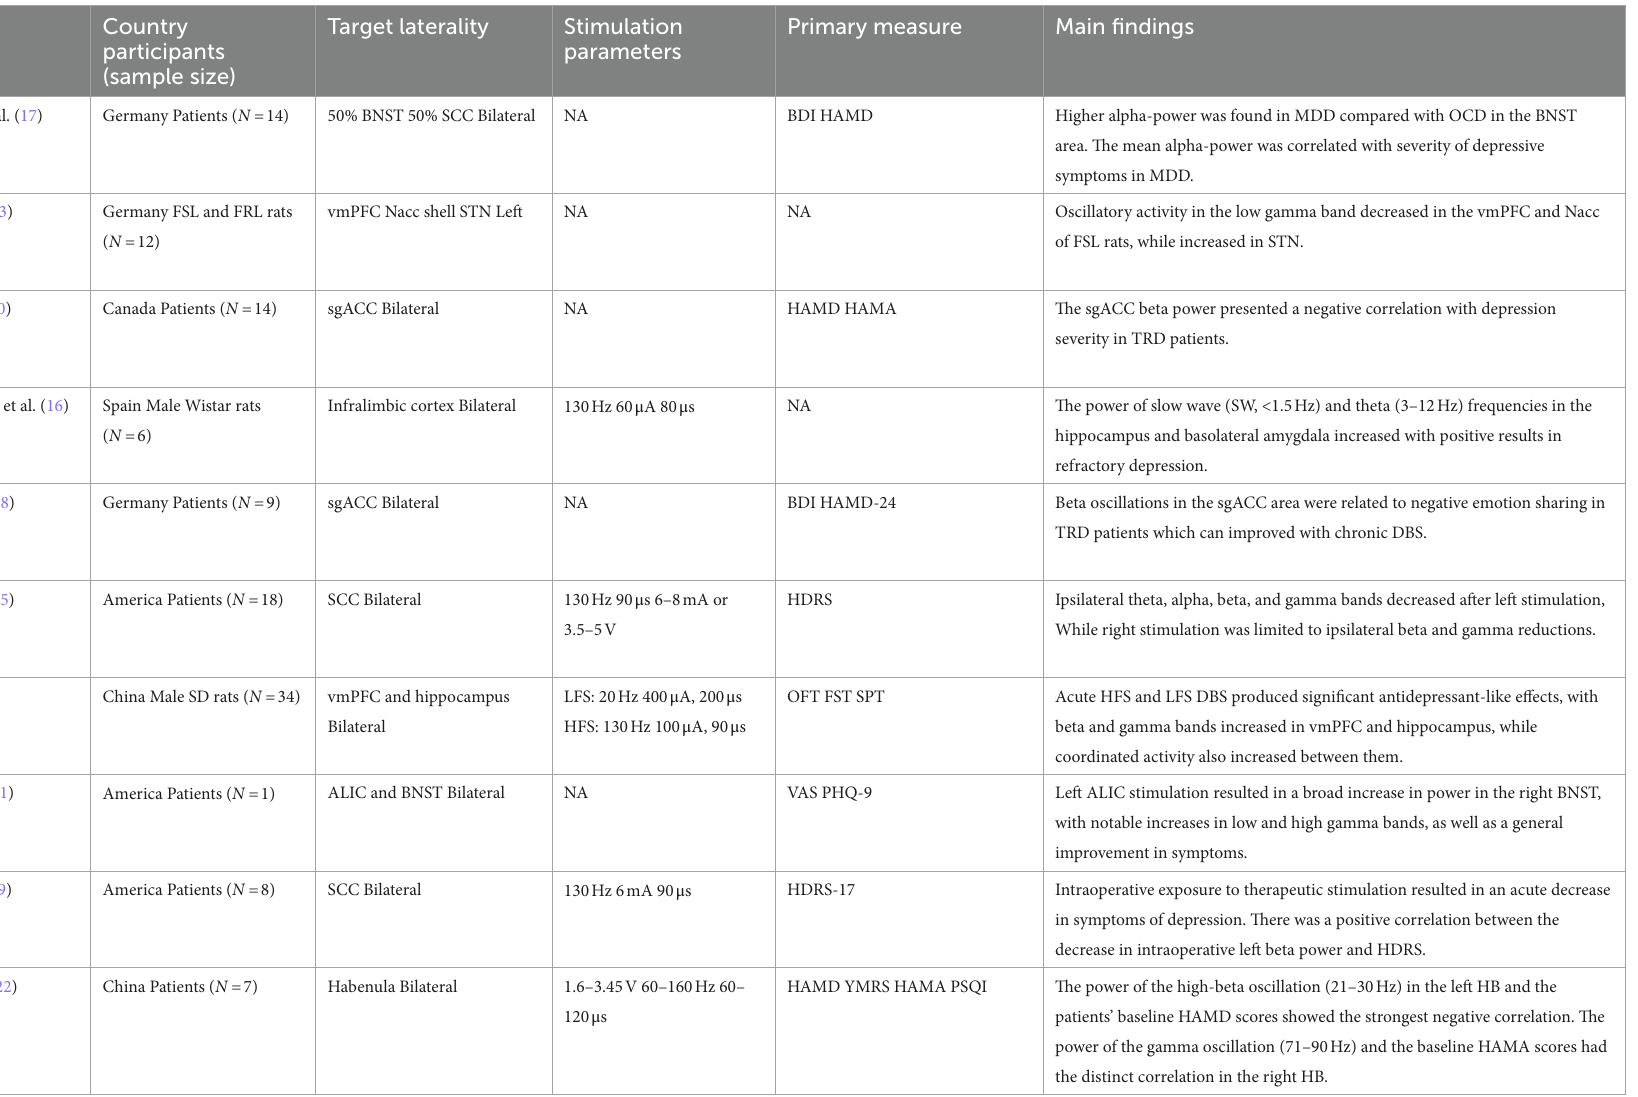
TABLE 2 Summary of recent studies on LFPs of